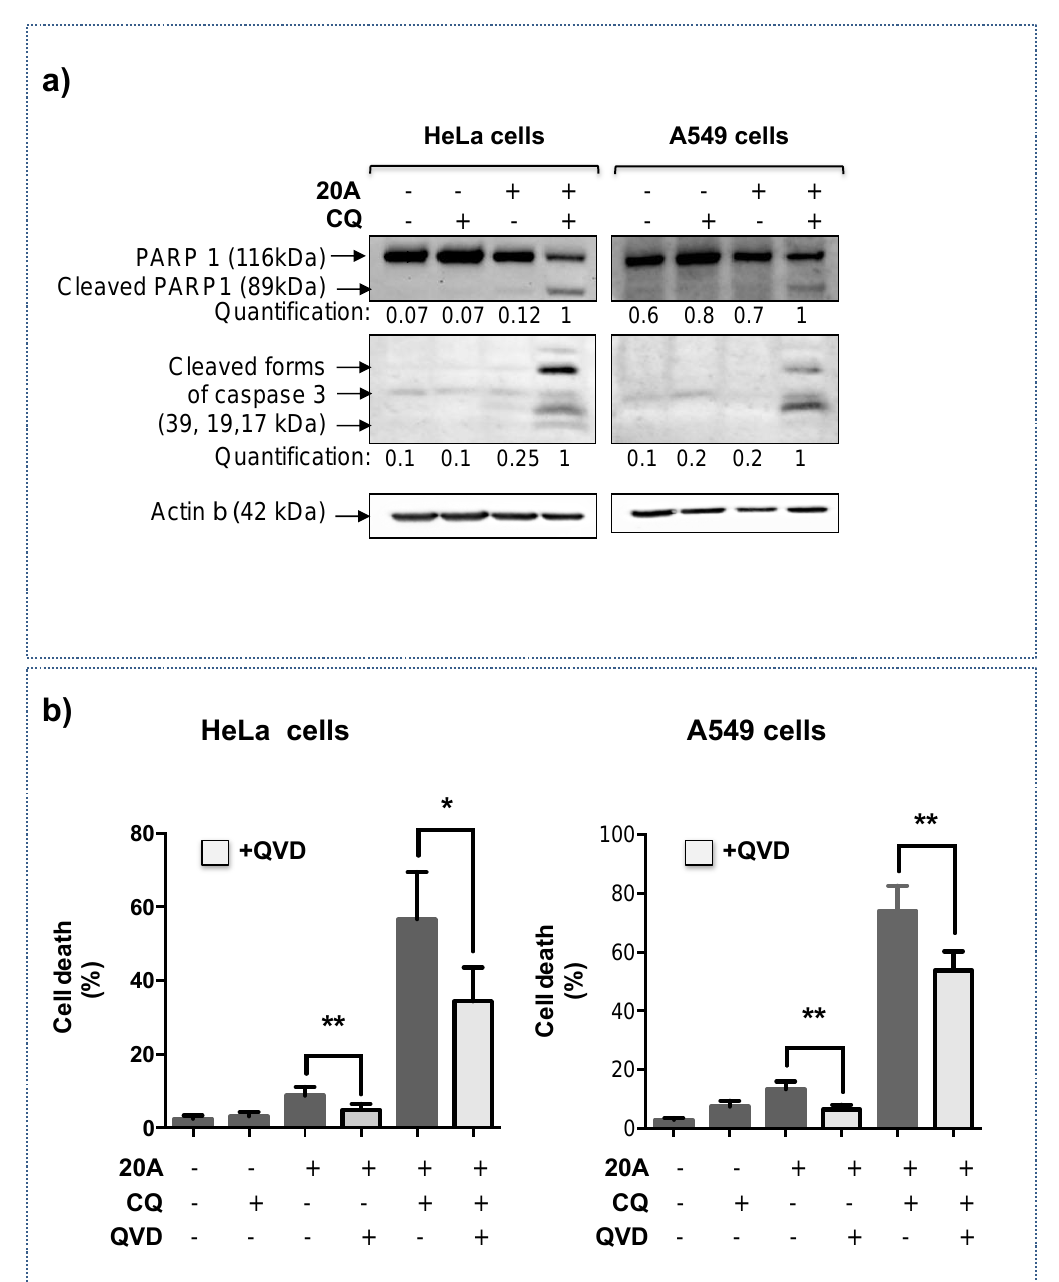
Figure 5. Apoptosis is involved in cell death induced by 20A plus chloroquine. ( a ) HeLa cells (left panel) and A549 (right panel) cells were treated with 5 µ M and 3.5 µ M 20A , respectively, in the presence or absence of 25 µ M chloroquine for 24 h. Apoptotic cell death was assessed by immunoblot analysis of cleaved forms of either Caspase 3 or PARP1. Actin β was detected as a loading control. The Western blots were quantified and given as ratio of cleaved caspase3 / Actin β or cleaved Parp1 / Actin β ( b ) HeLa cells (left panel) and A549 (right panel) cells were treated with or without 20 µ M QV-D-Oph two hours prior to the addition of 20A (5 µ M and 3.5 µ M for HeLa cells and A549 cells, respectively). Where indicated, cells are also exposed to 25 µ M chloroquine (CQ) for 24 h. Cell death was assessed by scoring propidium iodide positive cells. The data represents the mean ± SD of six values obtained from three independent experiments each performed in duplicate (* p value < 0.05 and ** p value < 0.01 using Mann-Whitney test).